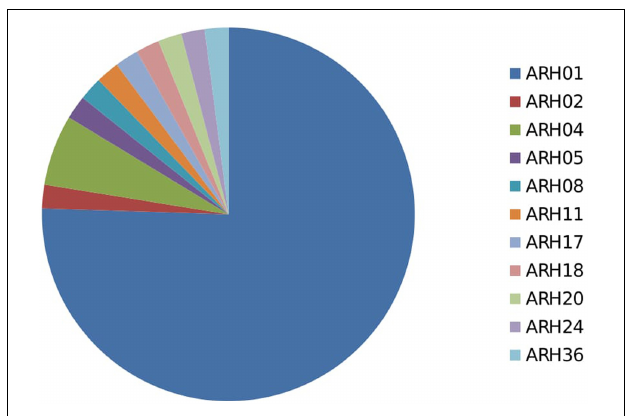
FIGURE 4 | Proportion of highly aggressive isolates from different haplotype